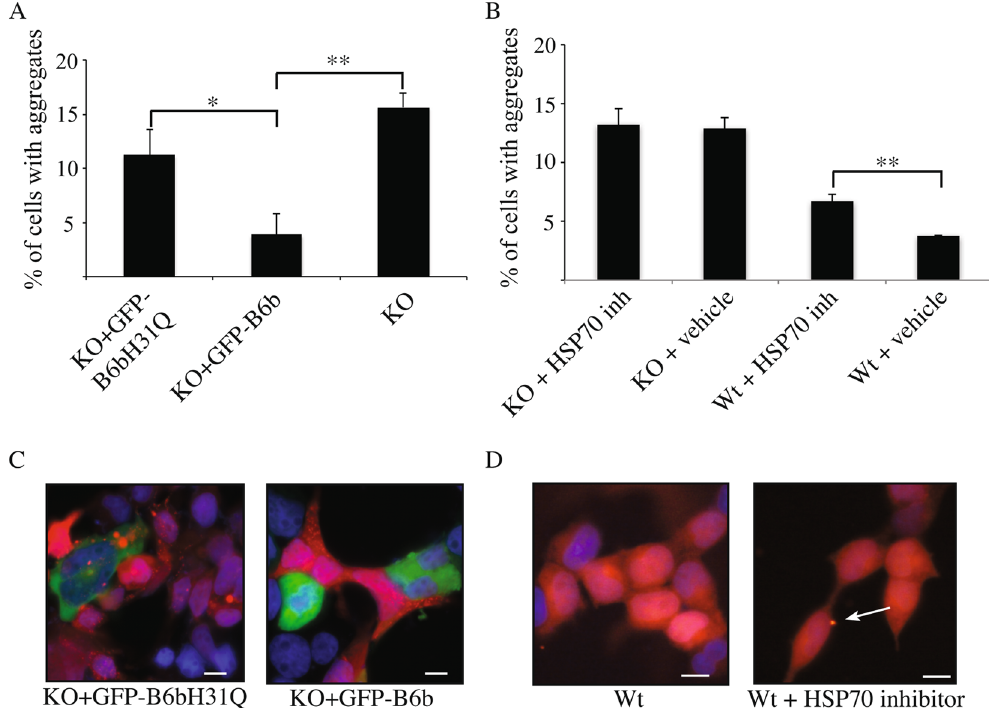
Figure 4. Increased aggregation caused by DNAJB6 KO is dependent on the catalytic function of the DnaJ domain. ( A ) Quantification of aggregation in KO cells transfected with GFP-DNAJB6 wild-type expression plasmid relative to KO cells transfected with GFP-DNAJB6-H31Q expression plasmid (n = 3). ( B ) Quantification of aggregation in WT and KO cells incubated with Hsp70 inhibitor VER-155008 at 10 uM for 2 hours, compared to cells incubated with vehicle control (n = 3). Statistical analysis was performed by One-Way ANOVA. * P < 0.05, ** P > 0.01. ( C ) Representative pictures despicting that wt DNAJB6b but not H31Q mutant DNAJB6b suppress α -syn aggregation by flourescnece microscopy. ( D ) Representative pictures demonstrating that increased number of α -syn aggregates were observed when the α -syn-DsRed HEK293T cells were incubated with the HSP70 inhibitor VER-155008 at 10 uM for 2 hours. Scalebar: 10 μ